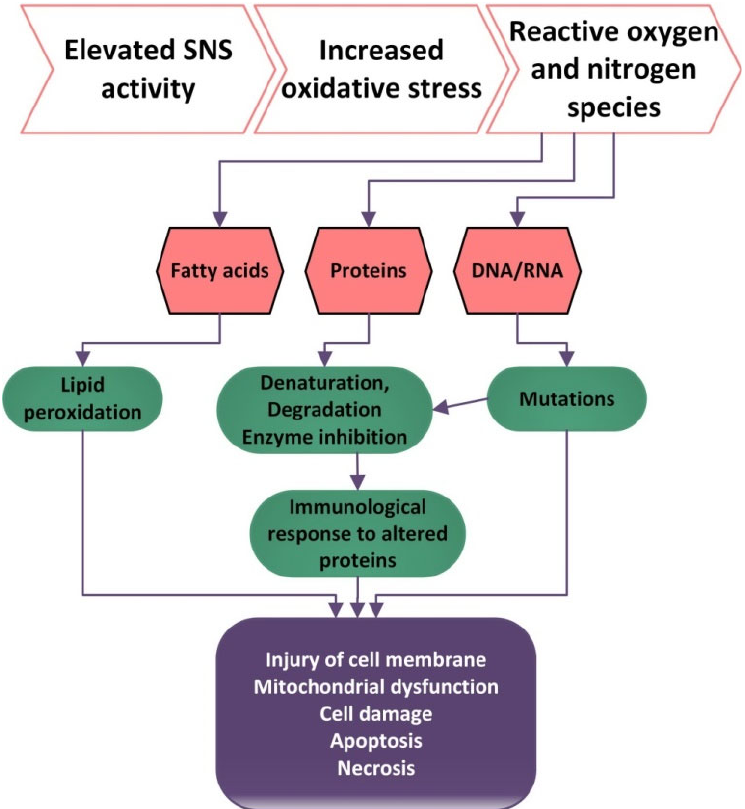
Figure 1. The pathophysiological mechanism by which oxidative stress contributes to the occur ‐ rence of various diseases. of various